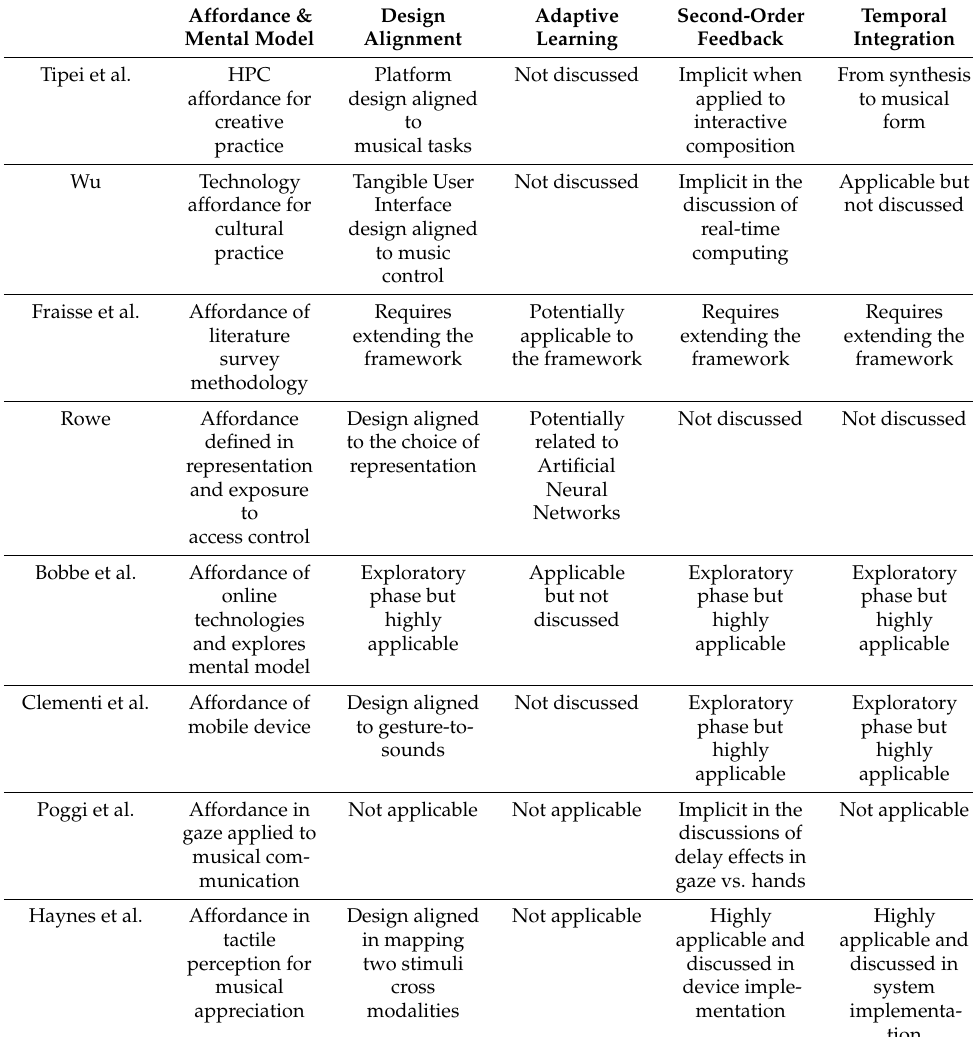
Table 1. Comparative summary of the contributing articles with respect to the proposed framework of five enabling